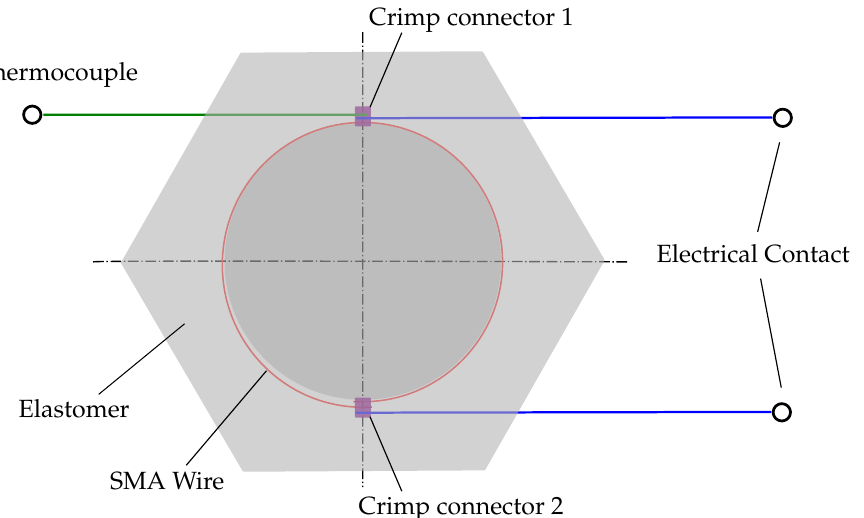
Figure A2. Cross-section presentation for electrical wire and thermocouple connection to the SMA wire, with the change from [19].